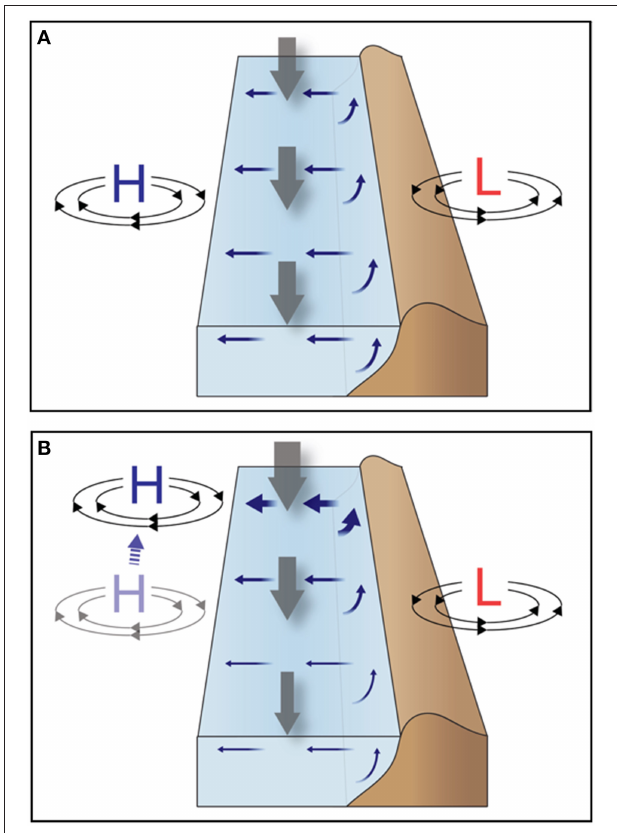
FIGURE 1 | Expected changes under climate change, from a Northern Hemisphere perspective. (A) Present: Pressure between ocean high- and land low-pressure systems drive upwelling-favorable winds (gray arrows) and thus upwelling (blue arrows). (B) Future: Poleward migration of ocean high-pressure systems, leading to enhanced (weakened) winds and upwelling in poleward (equatorward) regions of eastern boundary upwelling